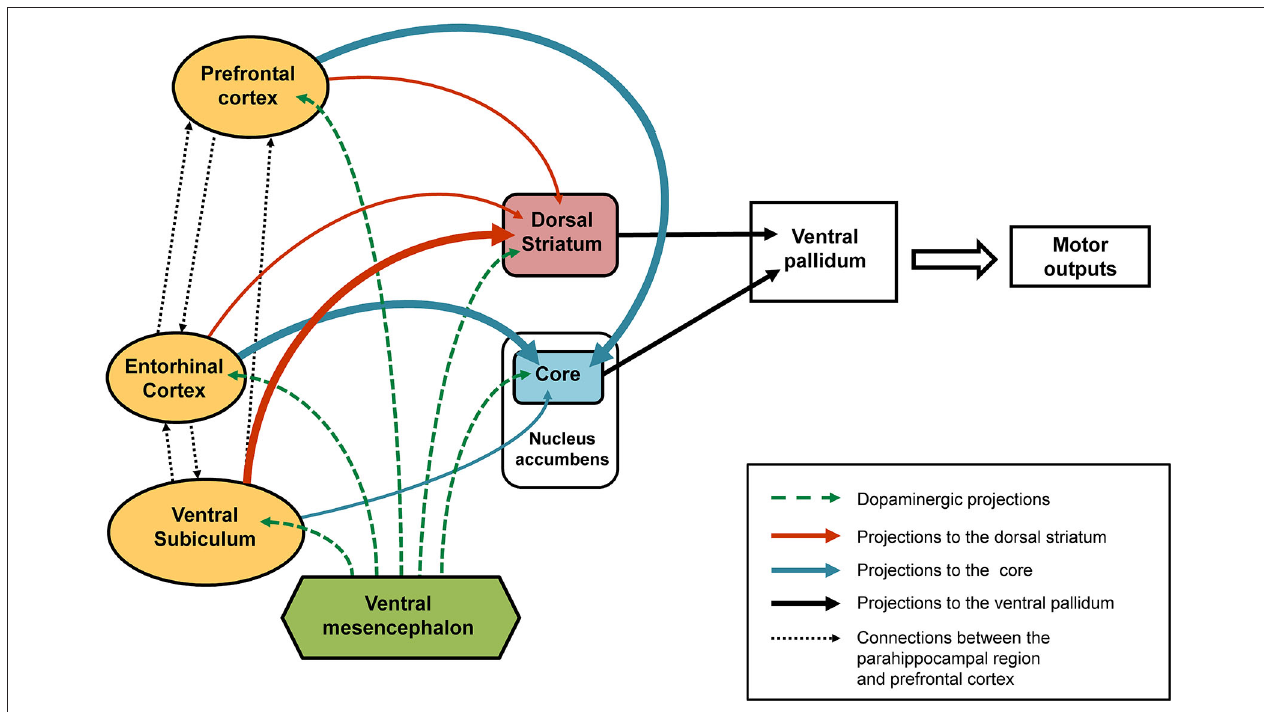
arrows) is exerted by the entorhinal cortex and the medial prefrontal cortex, whereas both these regions have little influence over the dopaminergic responses recorded in the dorsal striatum (thin orange arrows). The broken green arrows denote dopaminergic projections from the ventral mesencephalon. We propose that the behavioral responses observed in latent inhibition are the result of functional complementarity at the level of the ventral pallidum (dorsolateral part), of dopamine- regulated efferents from the dorsal striatum and the core part of the nucleus